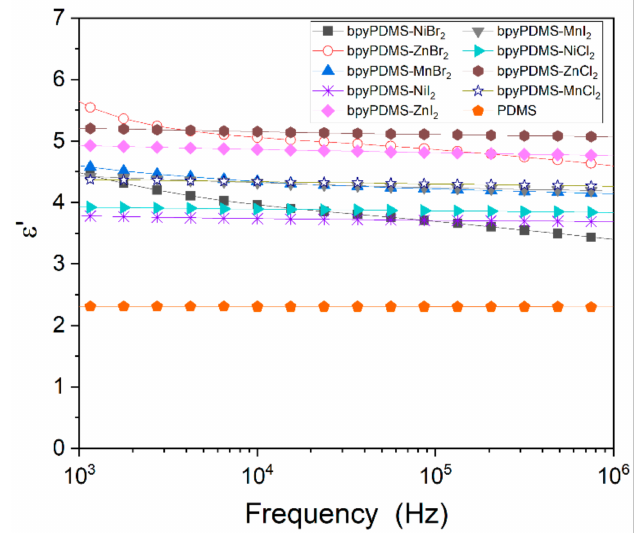
Figure 3. Frequency dependence of the real part of dielectric permittivity ε (cid:48) at 293 K for PDMS and organometallic